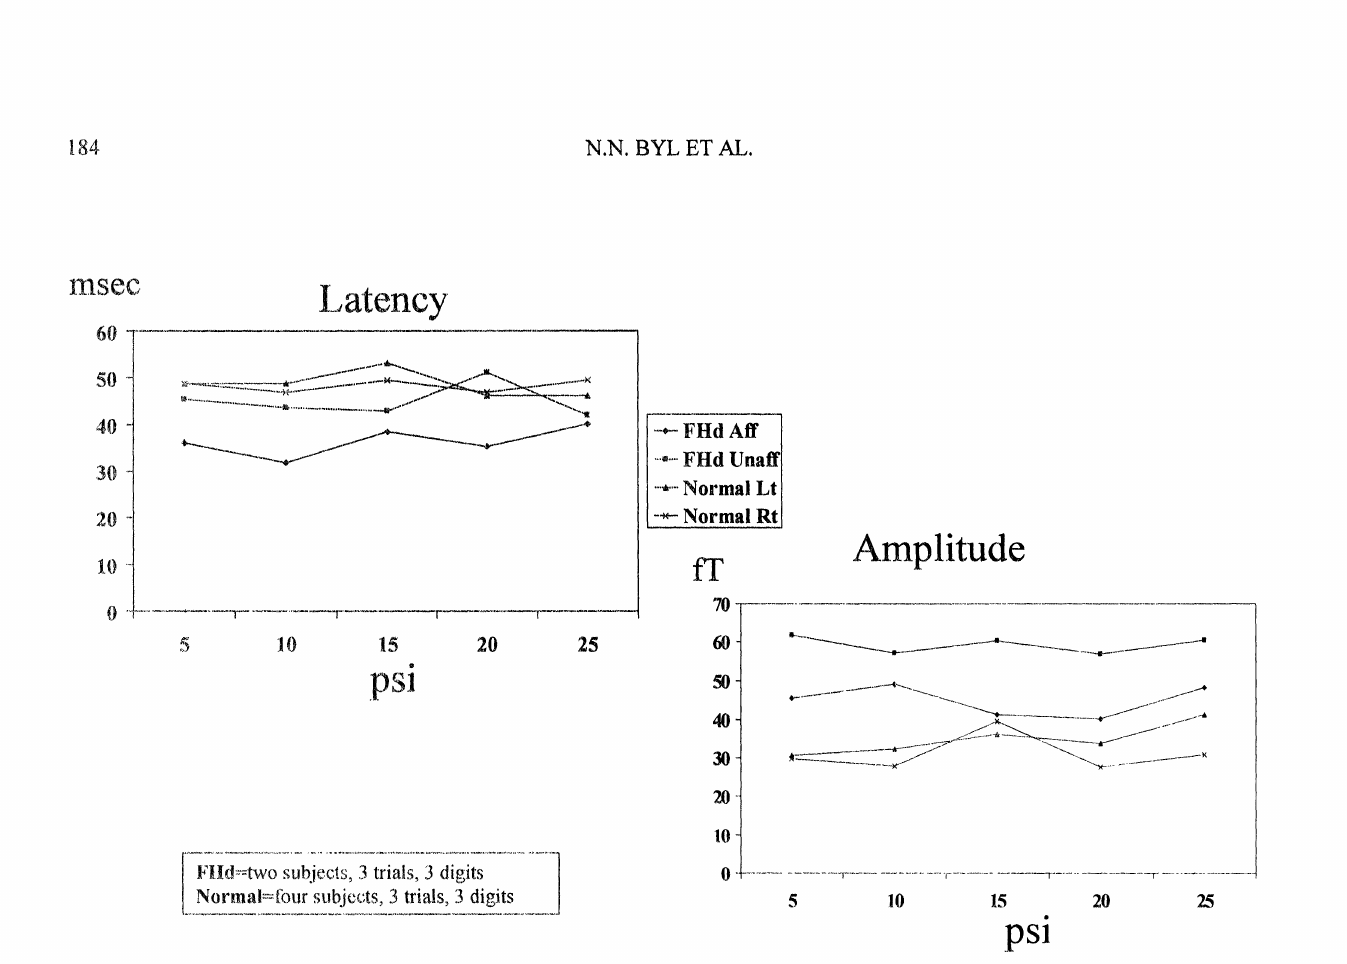
FHd=two subject.s, 3 trials, 3 digits Normal=four subjects, 3 trials, 3 digits